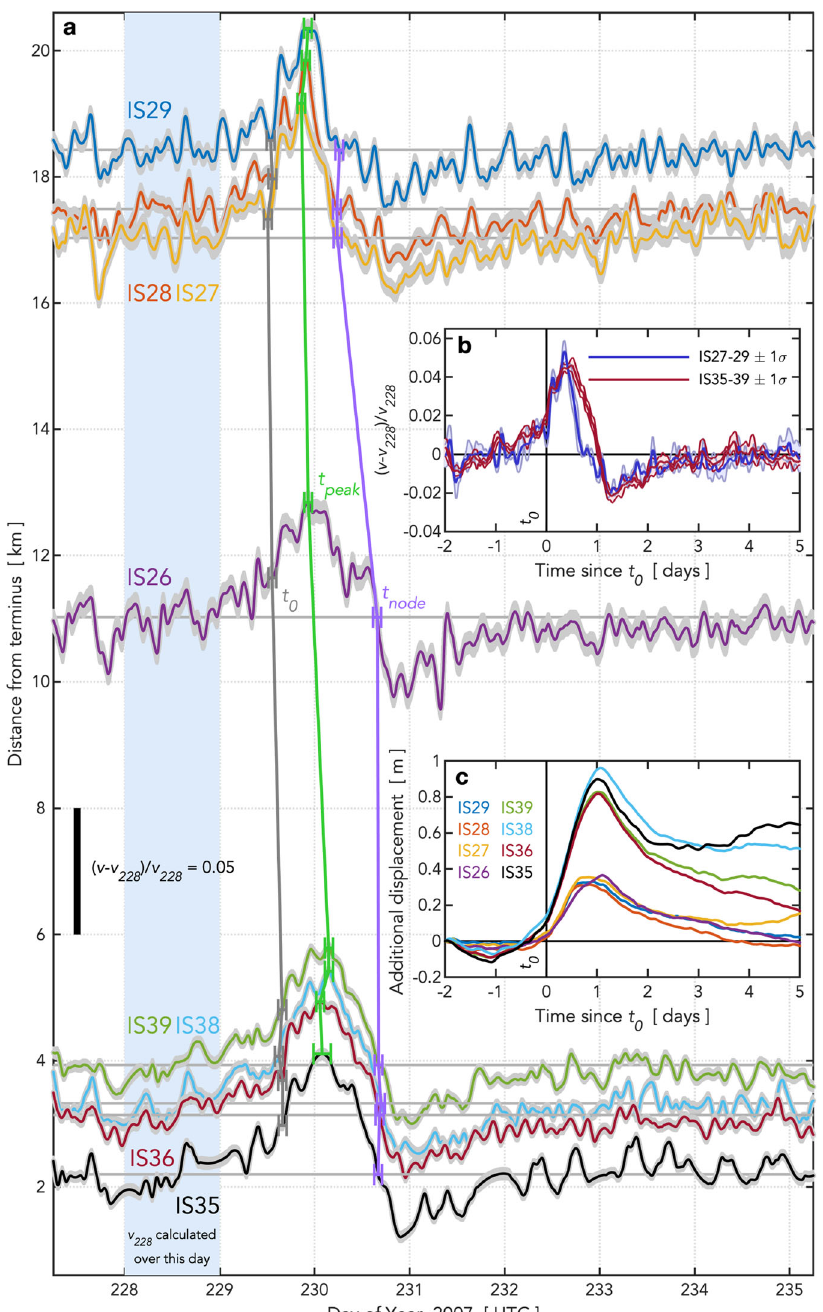
Fig. 2 | Glacier velocities during supraglacial lake drainage. a Along- fl ow velo- cities v plotted as ð v (cid:2) v 228 Þ = v 228 , where v 228 are individual average station velo- cities on 2007/228. Gray shading shows ±1 σ errorson the velocity ratios. Black bar gives the velocity-ratio scale. Along- fl ow velocities are plotted by station distance fromthe glacierterminus;the y-interceptof eachhorizontalgraylineisthe station distance from the terminus. Time of (gray) t 0 , (green) t peak , and (purple) t node shown for each station with ±1 σ error bars in time. b Averaged velocity pulse